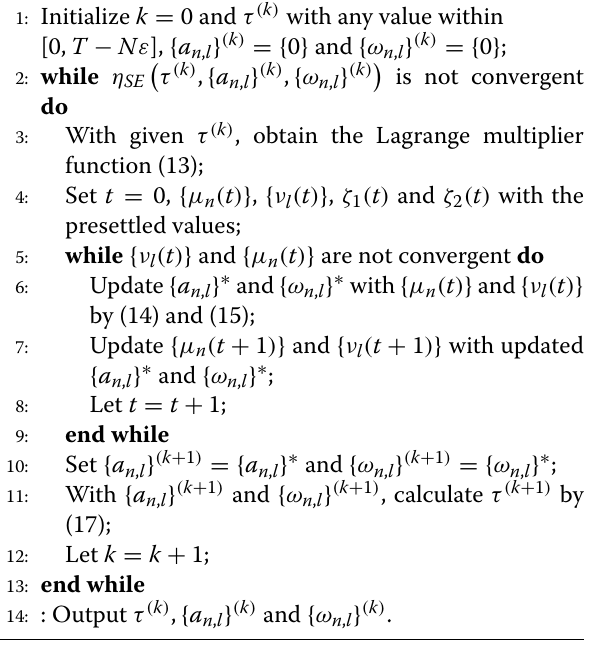
Algorithm 1 Joint optimization algorithm based on